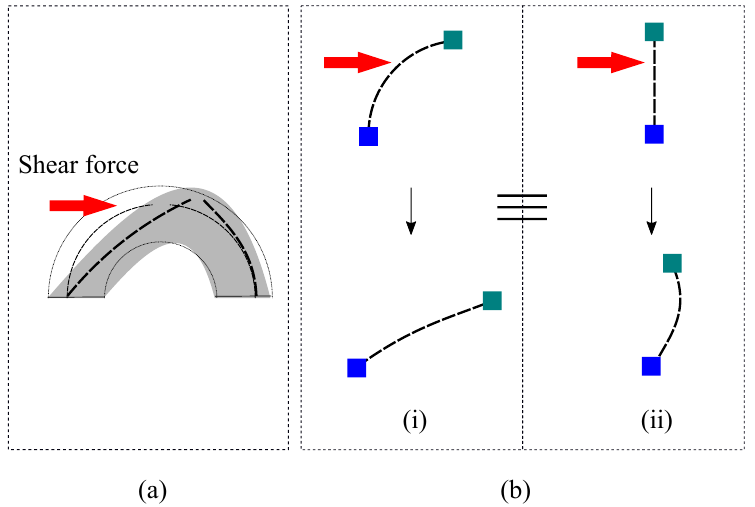
Figure 7. Effect of applying ( a ) shear force on the sensor ( b ) equivalent systems; blue squares represent fixed and greenish ones portray partially moving boundary conditions; in both of the cases, red arrows symbolize applied force